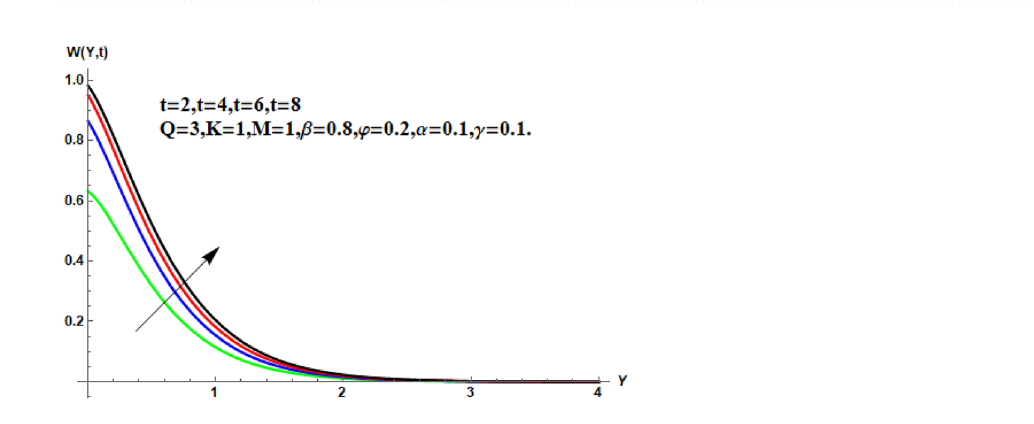
Figure 11. Velocity profile for different values of γ .